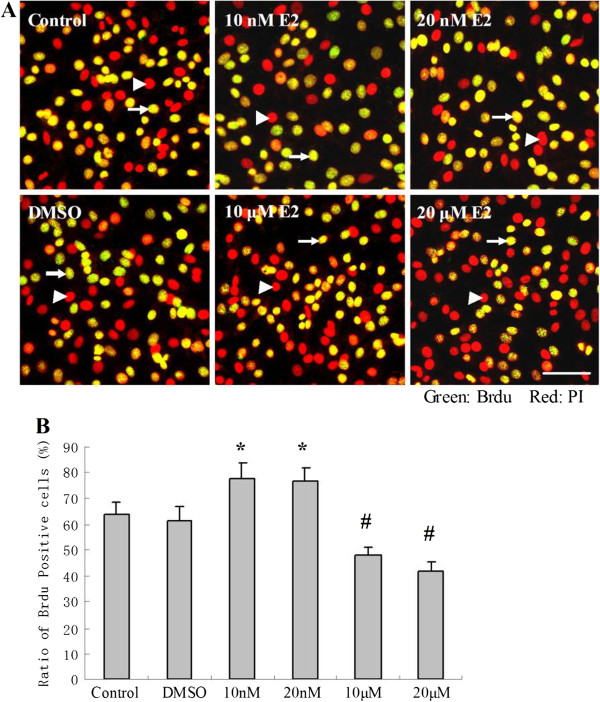
The effects of different doses of E2 on cultured PC12 cell proliferation assessed by Brdu incorporation assay. (A) The triangle represents the nuclei labeled by PI dye (Red), and the arrow represents the replicating DNA by BrdU incorporation (Green). (B) The ratio of Brdu-positive cells in 10 nM and 20 nM E2 groups significantly increased (*p < 0.01, compared with the control and DMSO groups), and the Brdu-positive cells in 10 μM and 20 μM E2 group markedly decreased (#p < 0.05, v.s. the control and DMSO groups).